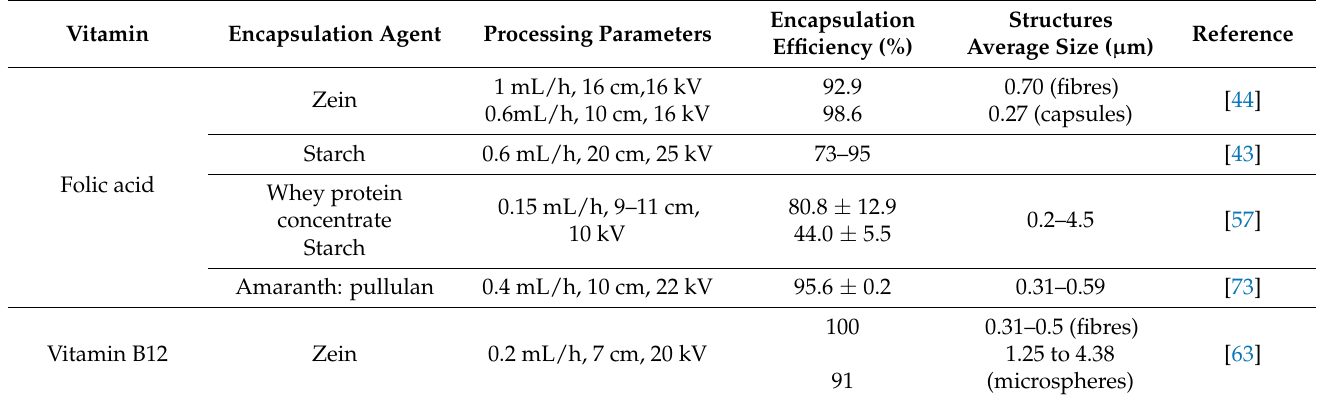
Table 4. Water-soluble vitamin encapsulation by electrospinning/electrospraying techniques for food and nutraceutical